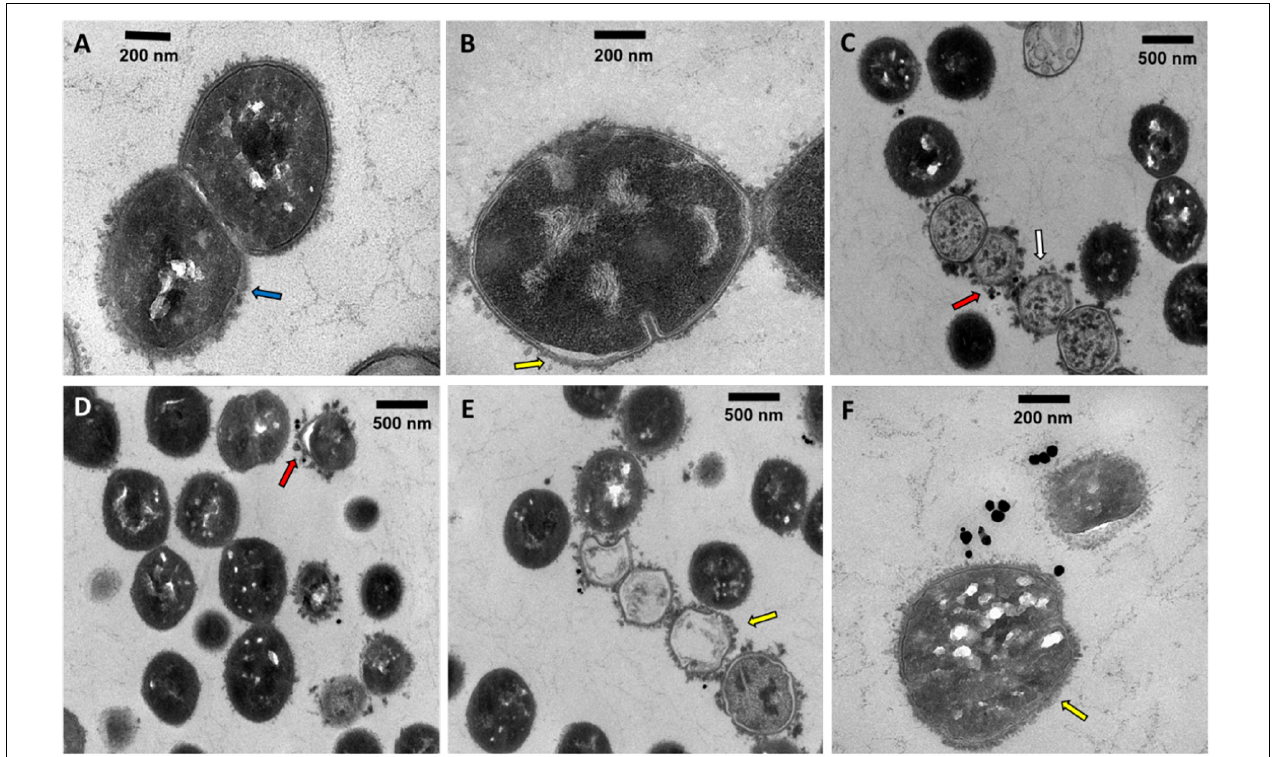
FIGURE 6 | Transmission electron microscopy microphotographs of SDSD VSD22 cells (A) untreated; (B,C) treated with AuAgNPs (10 nM) combined with visible light irradiation at 2.02 W cm − 2 for 60 s; (D–F) treated with AuAgNPs alone. Blue arrow shows glycocalyx from untreated cells; Yellow arrow shows cell envelope not defined with wrinkling of the cell wall; Red arrows show nanoparticles adhered to the cell envelope; White arrow shows aggregation of the cytoplasmic components.